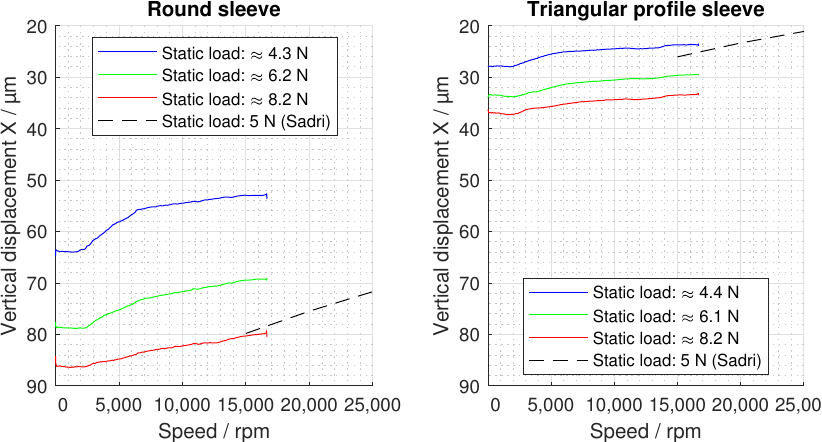
Figure 10. Eccentricities (relative to the centre point of the bearing determined by the tests with non-rotating shaft) and the results of Sadri [25].